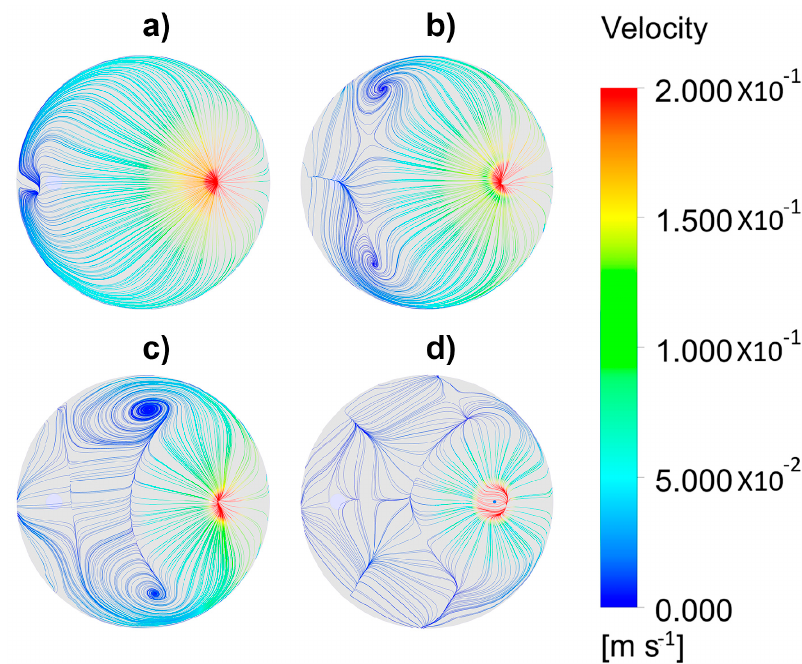
Figure 12. Streamlines of the flow for different thicknesses of the upper layer for a gas flow rate of 1.07 × 10 − 4 m 3 /s. ( a ) 0 m, ( b ) 0.01 m, ( c ) 0.02 m, and ( d ) 0.04 m.